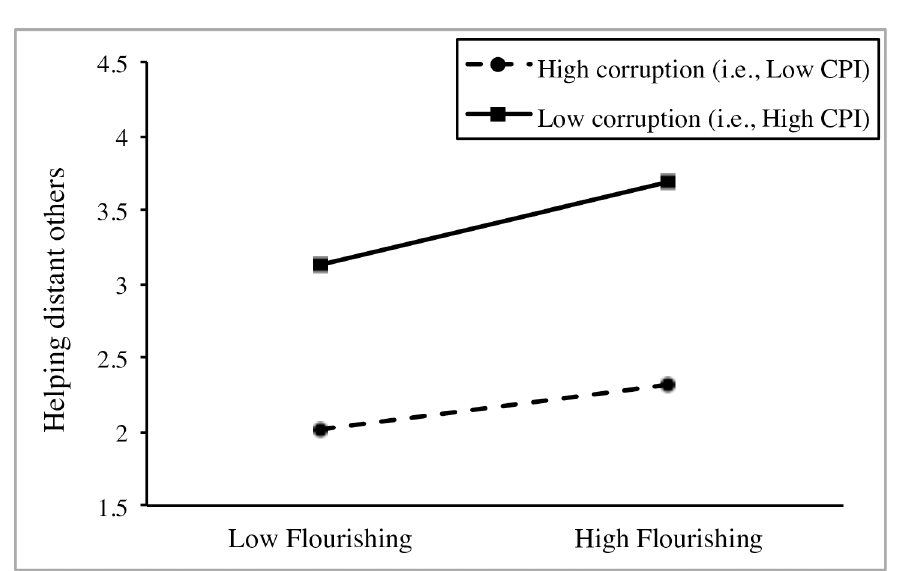
Fig 2. Cross-level interaction between flourishing and CPI on helping distant others in Study